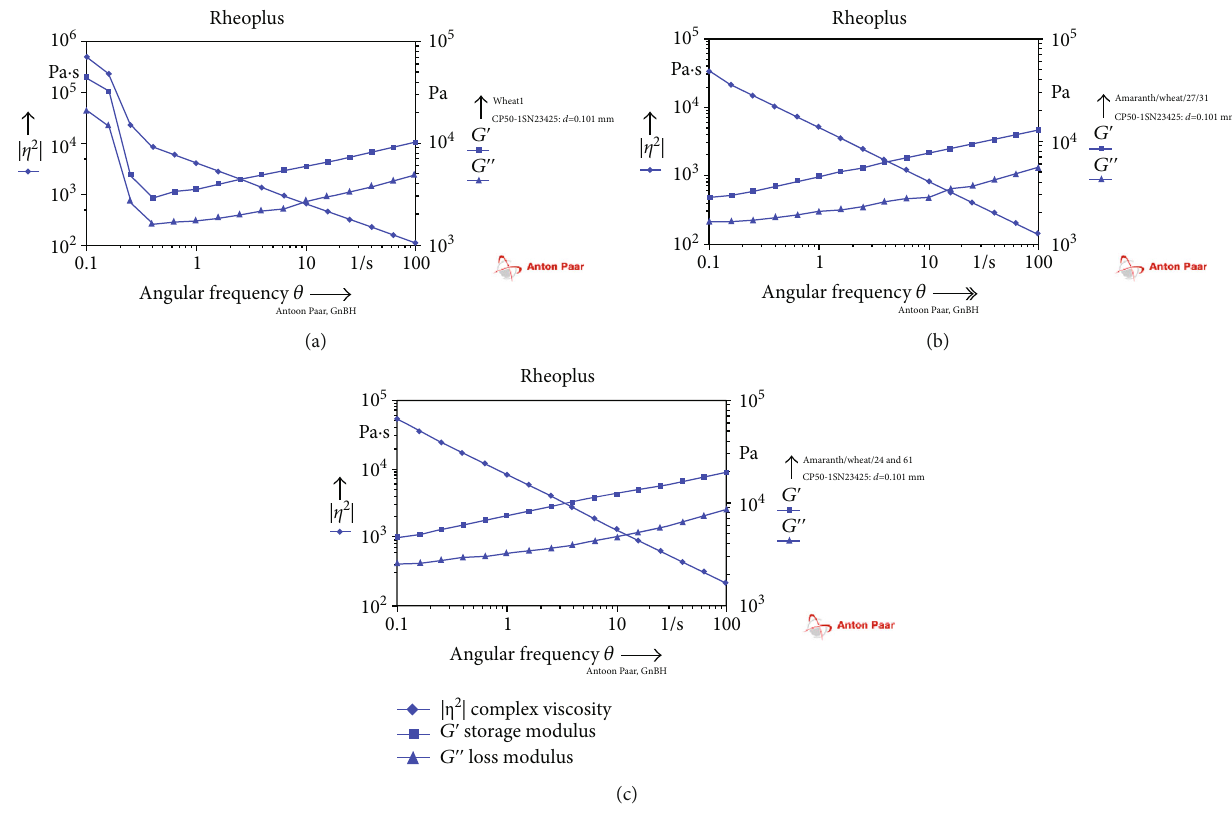
Figure 1: Plots showing variations in G ′ and G ″ as a function of angular frequency for a range of (a) 5% amaranth fl our+95% wheat fl our; (b)